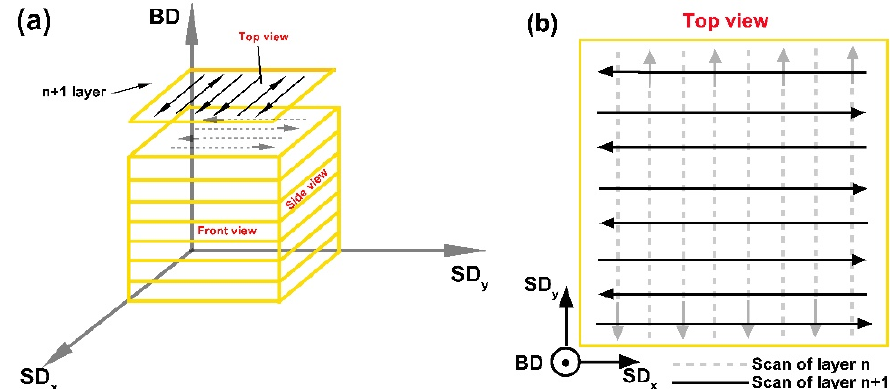
Figure 2. Overview of the AM processing strategy. The build (BD) and scan directions (SD x and SD y ) are indicated with respect to the sample coordinates: ( a ) the different views of the sample; ( b ) top view of the sample with the bidirectional scan vectors.